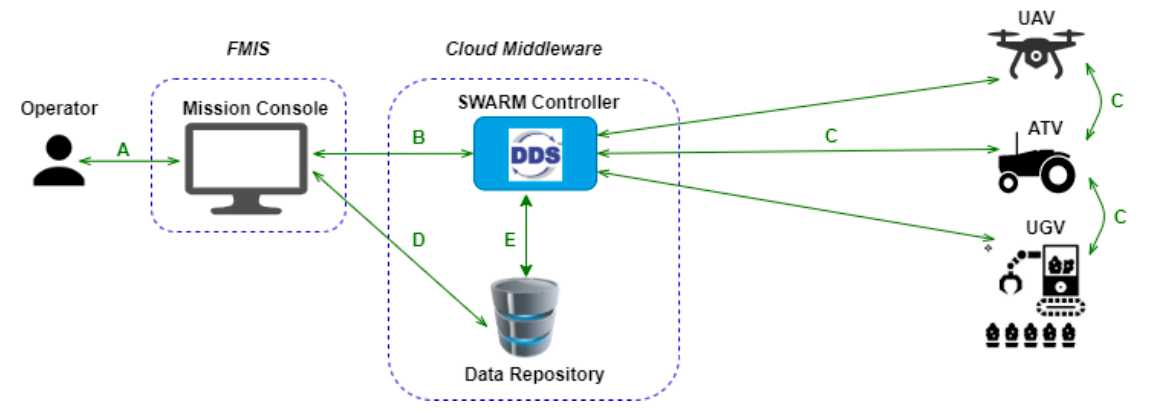
Figure 1. Core components of a system to manage missions with a swarm of autonomous vehicles.